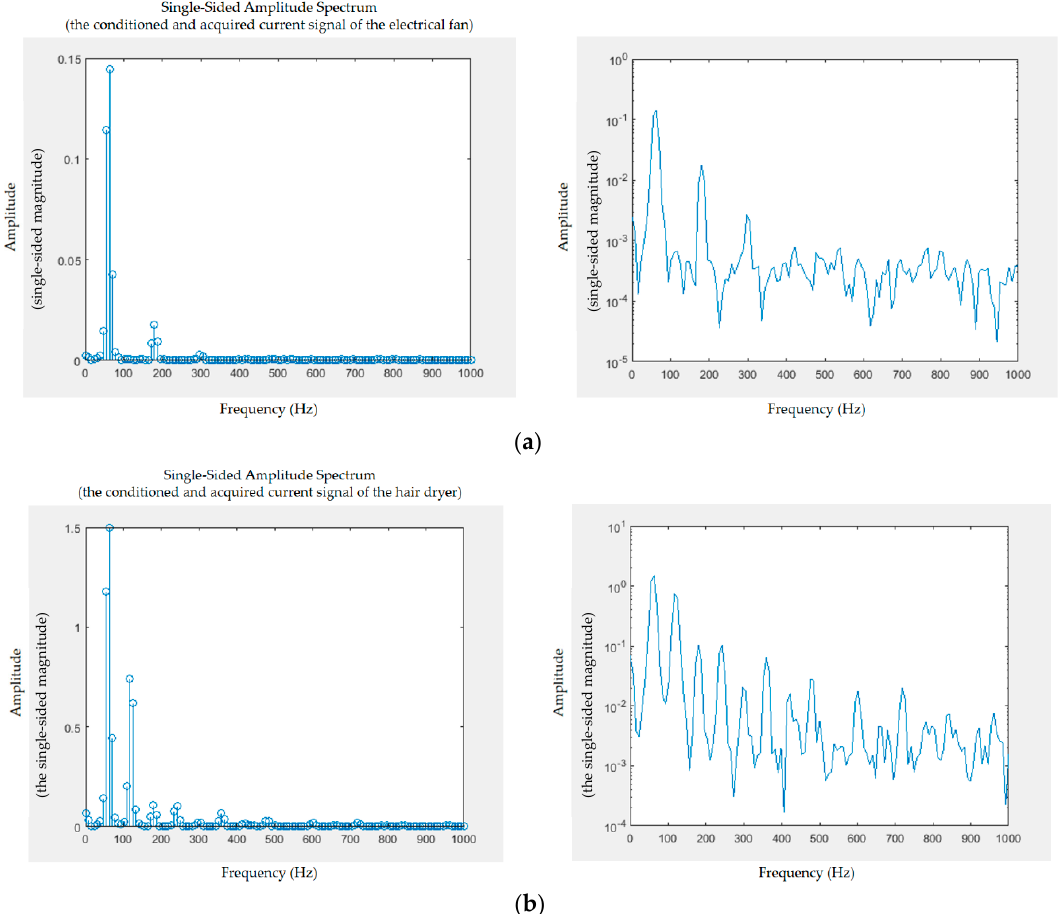
Figure 9. Frequency-domain single-sided amplitude spectra: ( a ) fast Fourier transform (FFT) applied for ( a ) electric fan in Figure 8a, and ( b ) hair dryer in Figure 8b. The fundamental frequency of the conditioned, acquired, and digitized current signals transformed is 60 Hz. On average, longer signals produce better frequency approximation. Note the logarithmic scale.